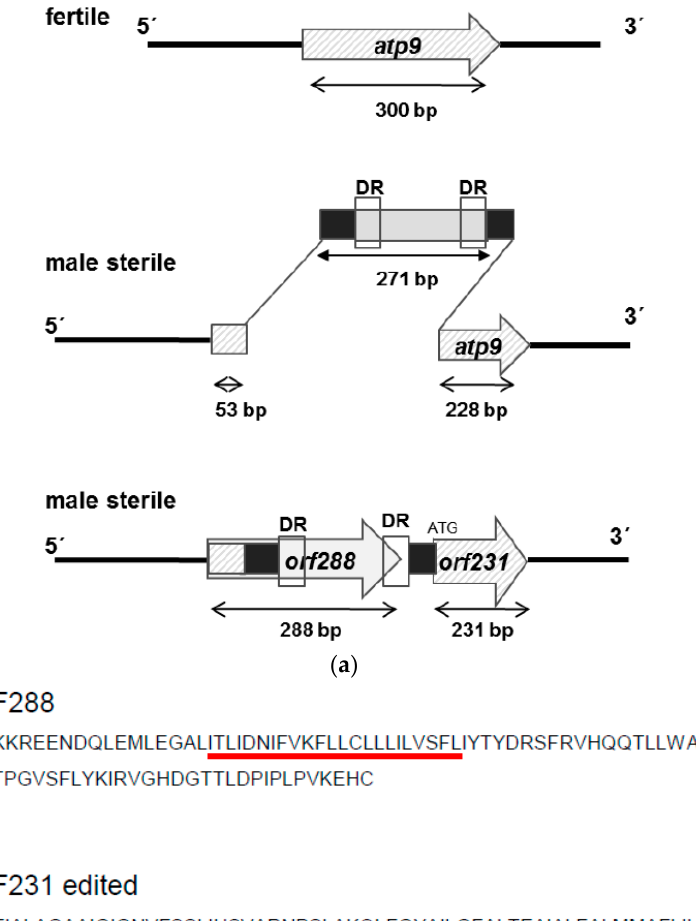
Figure 6. Model for the creation of the CMS-PET2 specific orf288 and orf231 by an insertion event of 271 bp into the duplicated atp9 gene. ( a ) Scheme; ( b ) Amino acid sequences of orf288 and orf231 (edited). Transmembrane domains as predicted by TMHMM are marked by red bars.